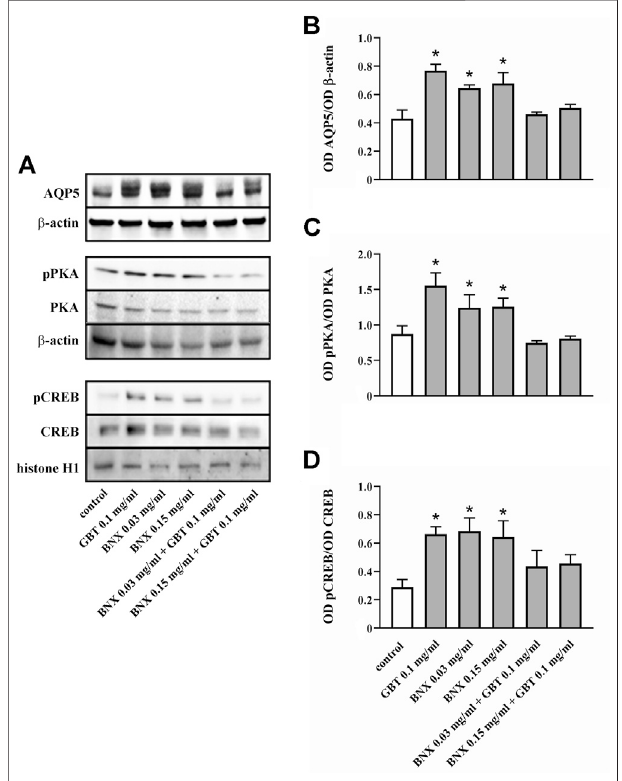
FIGURE 8 | Level of AQP5 and downstream mediators in HCE-F cells treated with 0.1 mg/ml GBT or BNX at 0.03 or 0.15 mg/ml, either alone or